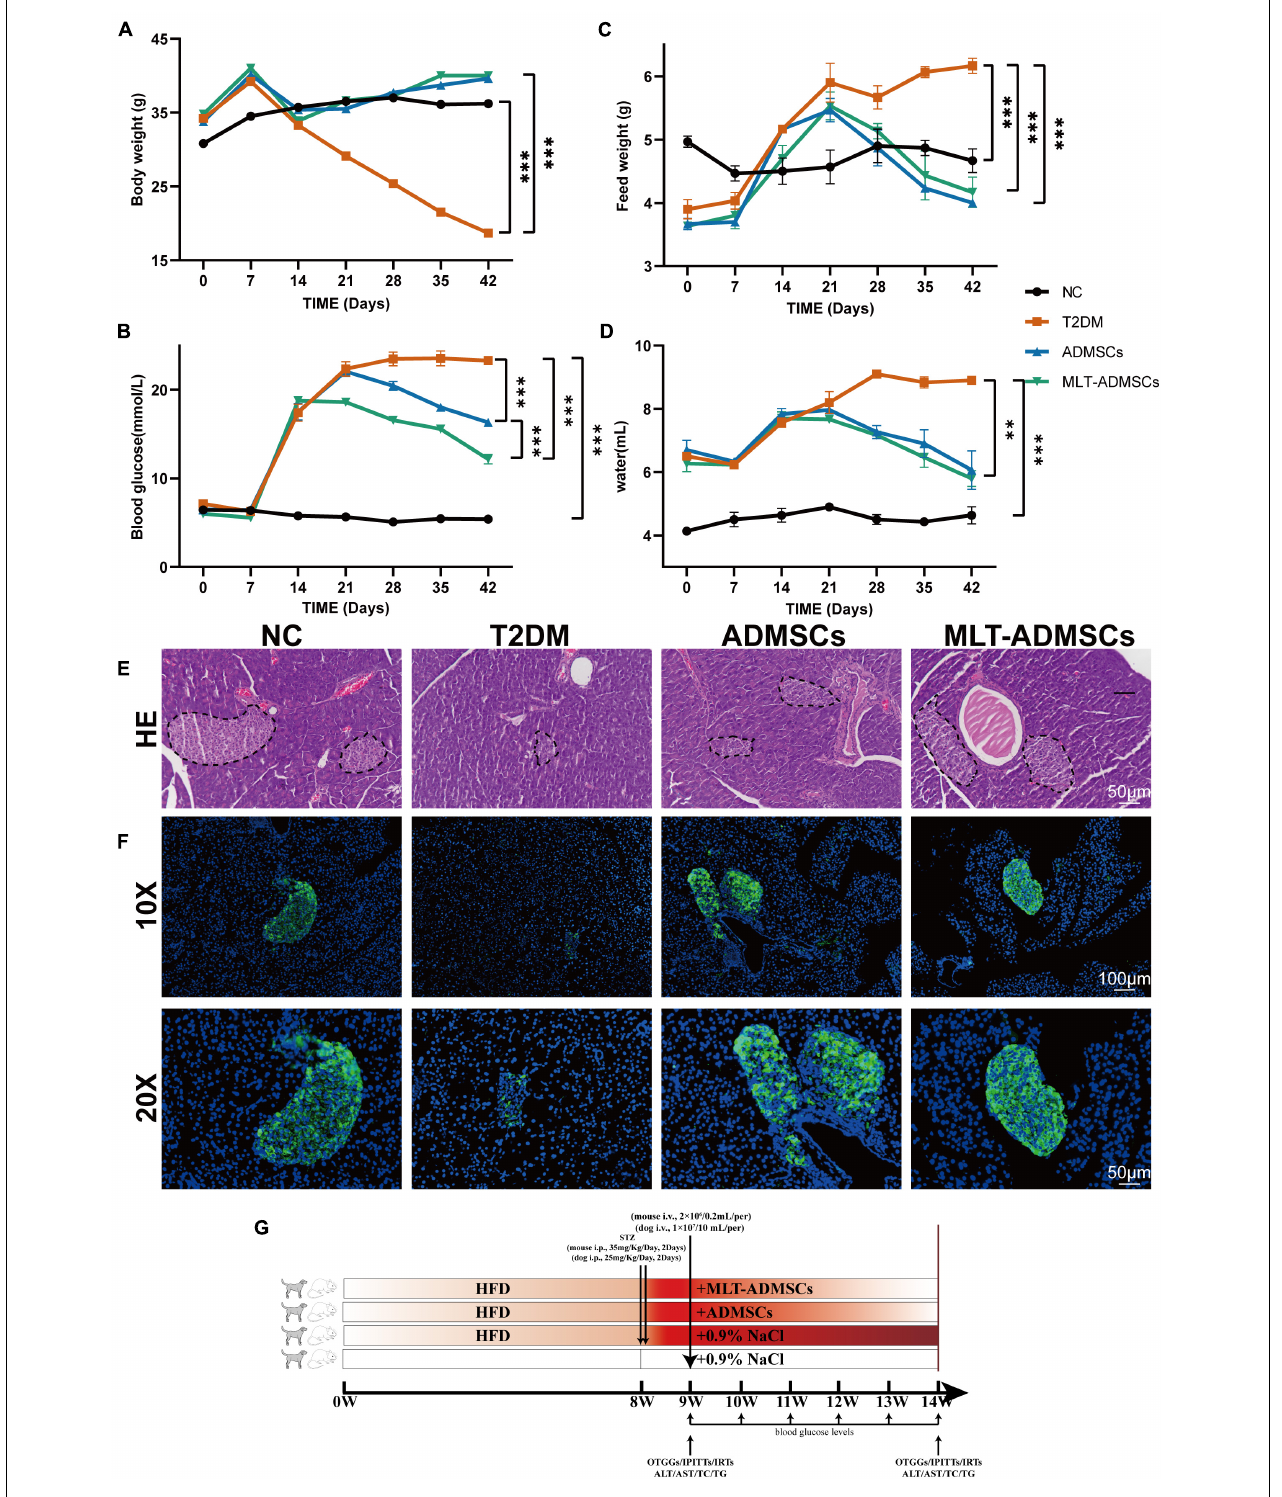
FIGURE 2 | MLT enhances the recovery effect of ADMSCs on clinical symptoms and hyperglycemia in T2DM mice and promotes islet reconstruction. (A) Continuous monitoring of the weight level of mice. (C) Changes in the feed intake of mice. (D) Changes in the water intake of mice. (B) Random blood glucose changes in mice. (E) Pancreas H&E staining. (F) Pancreas immunofluorescence insulin. (G) Experimental design. Values in this figure are the mean ± SE; n = 10 mice per group; ∗∗ p < 0.01, ∗∗∗ p < 0.001 determined by a repeated-measures ANOVA.